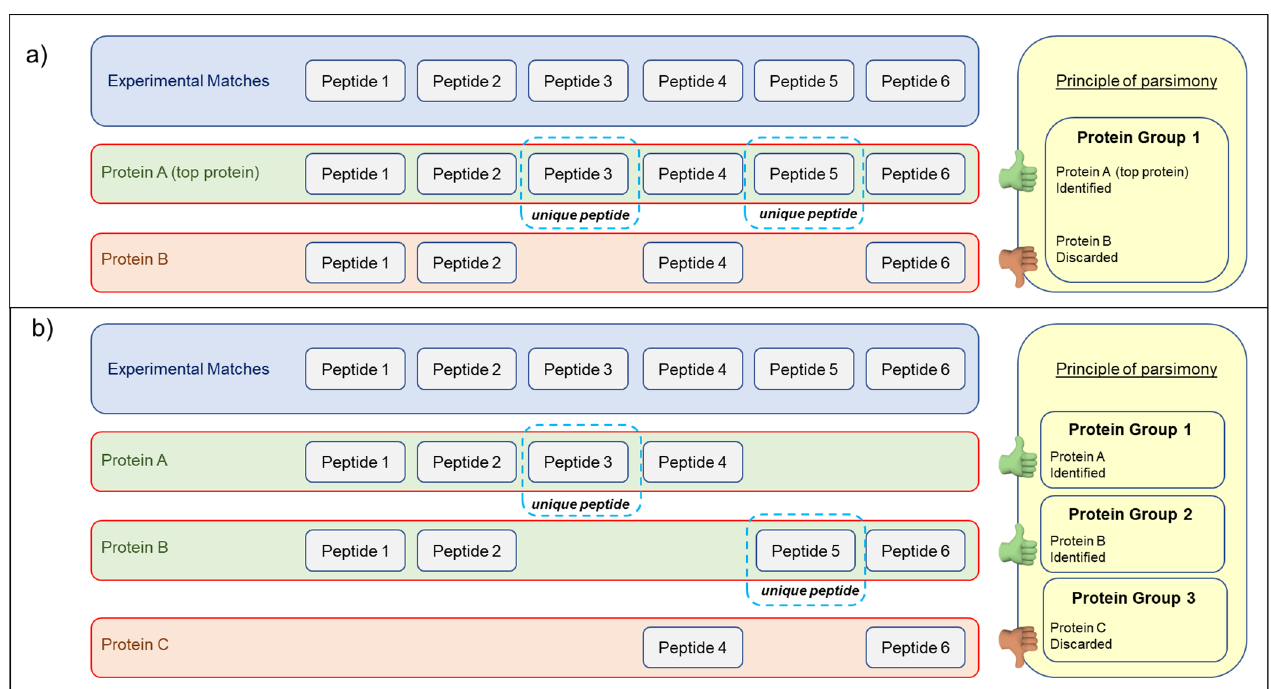
Figure 4. The fundamentals of Occam’s razor strategy (principle of maximum parsimony) in Prote- omics, by which proteins can be related through shared matches, and used to create the final report of the identified proteins. ( a ) B is a subset of protein A. Protein B may be present in the sample, but there is no evidence for this, so parsimony may be dropped from the report. ( b ) Protein C can be considered as an “intersection protein” (i.e., a subset of the combined matches to A and B). By Oc- cam’s razor, it may be discarded from the report because it is not identified by unique peptides.